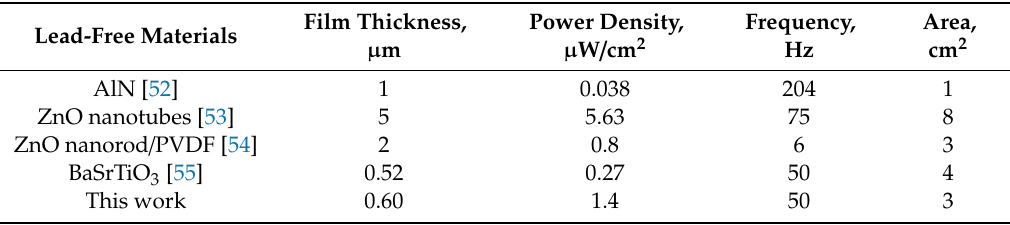
Table 4. Comparison of the energy harvesting performance of elements with a similar design, involving lead-free